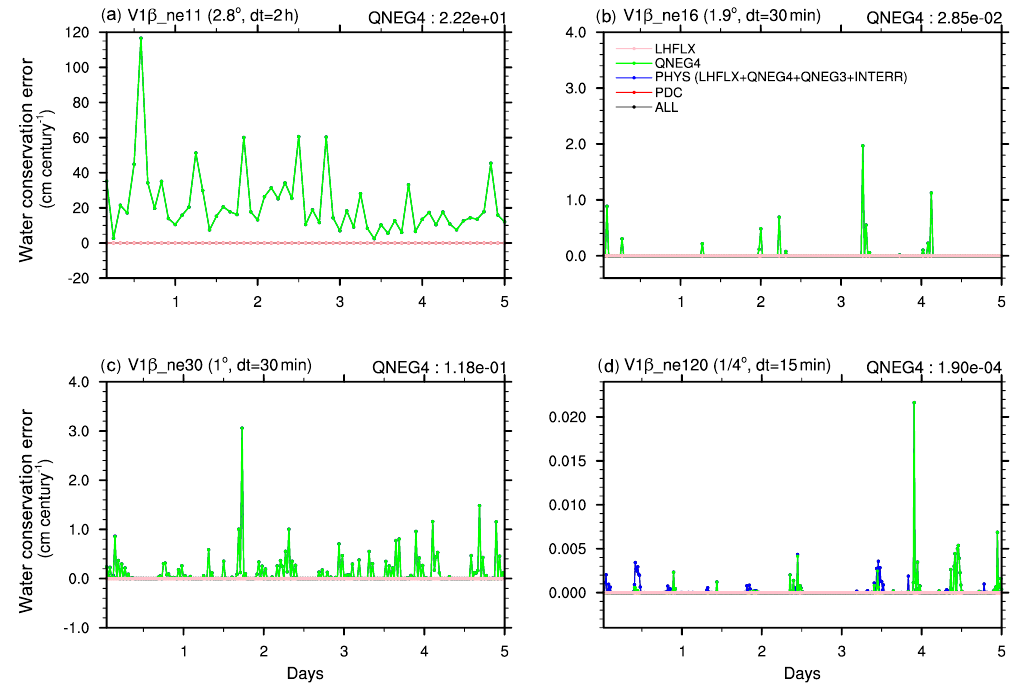
Figure 5. Water conservation error in 5-day simulations conducted with the E3SM V1 β model at different resolutions.